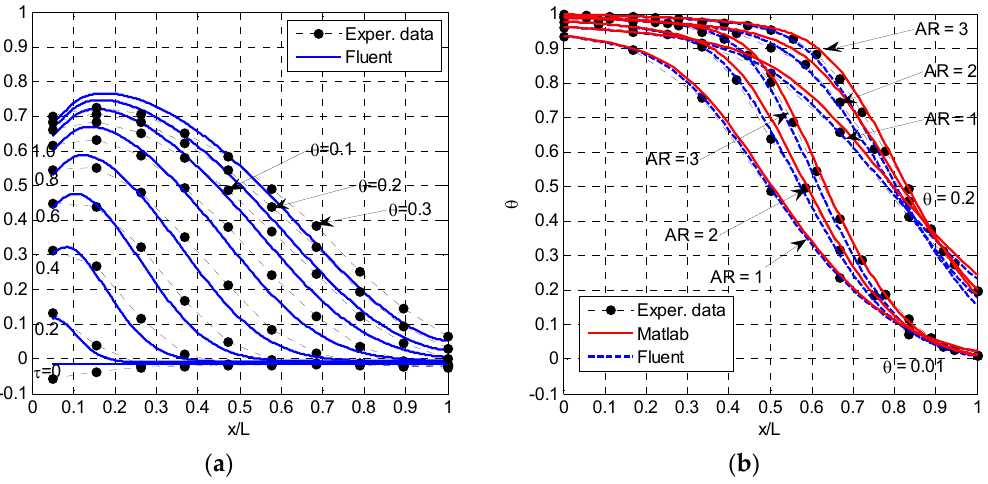
Figure 10. ( a ) Wall temperature distribution for θ up to 0.3 at the outlet section; ( b ) Influence of aspect ratio on axial temperature profile.